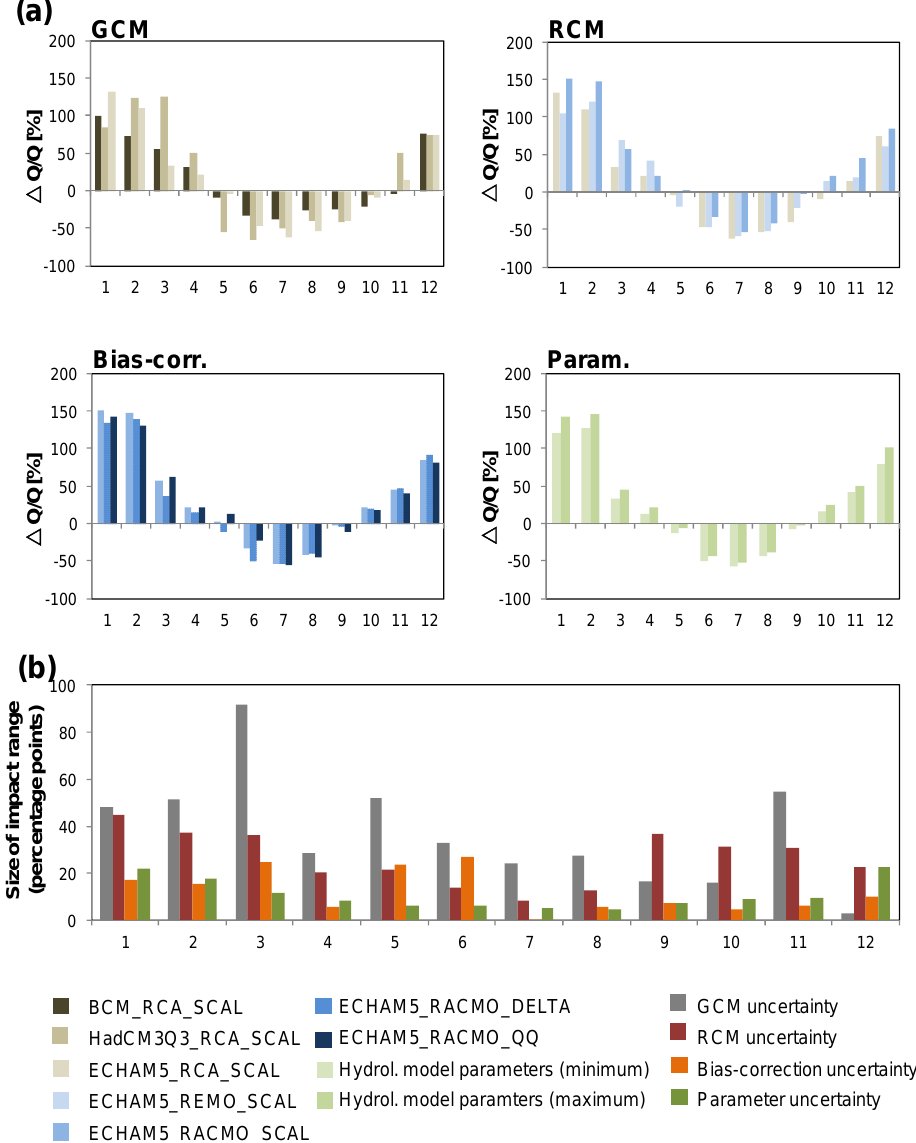
Fig. 8. (a) Uncertainty in the projections of mean monthly runoff ( Q ) resulting from GCM, RCM, bias-correction and hydrological model parameters. (b) Size of impact range originating from each uncertainty source. The differences (percentage points) between the minimum and maximum values are plotted.